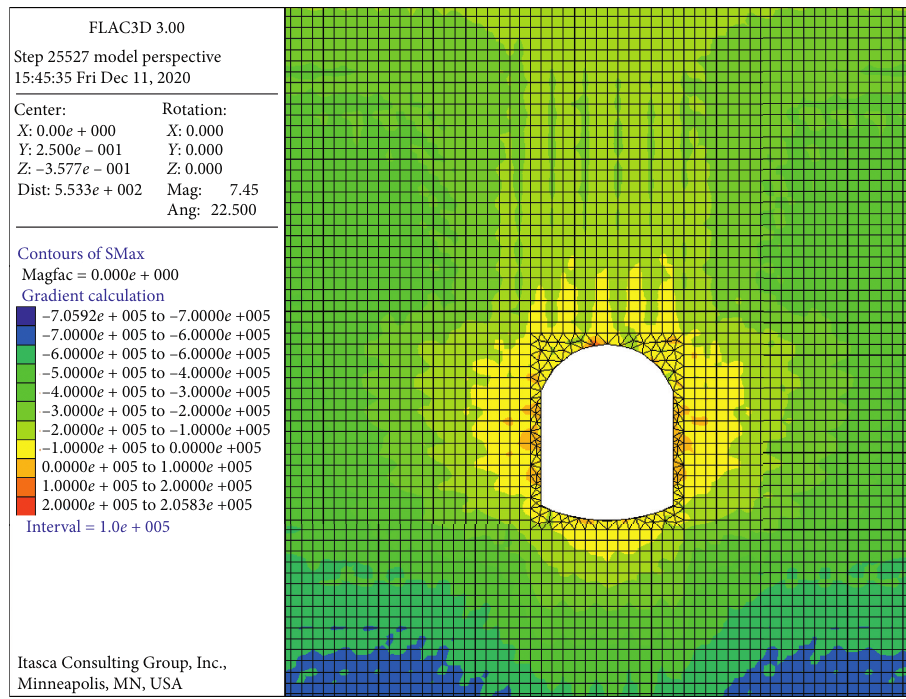
Figure 3: Principal stress distribution of surrounding rock.